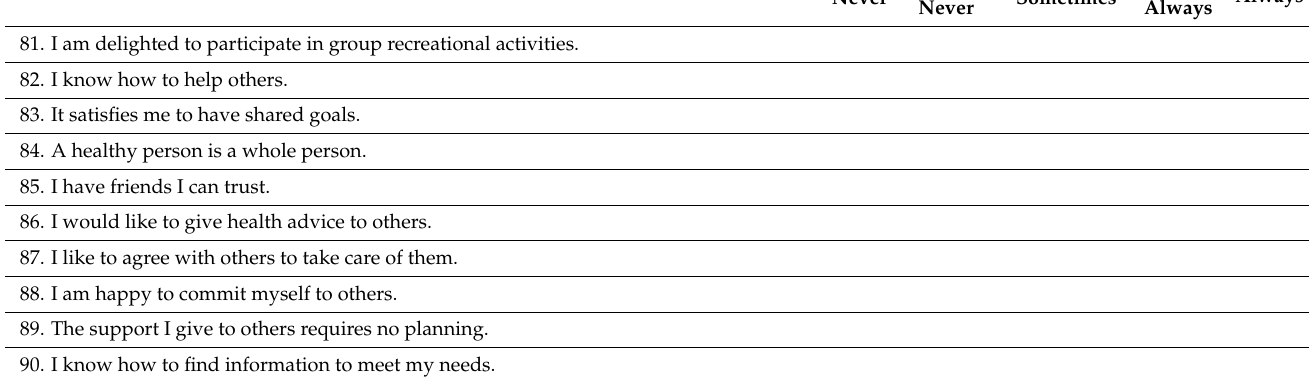
Table A2. Generatividad relativa a la salud (GeReH) (Spanish version). A continuaci ó n, hay una serie de afirmaciones